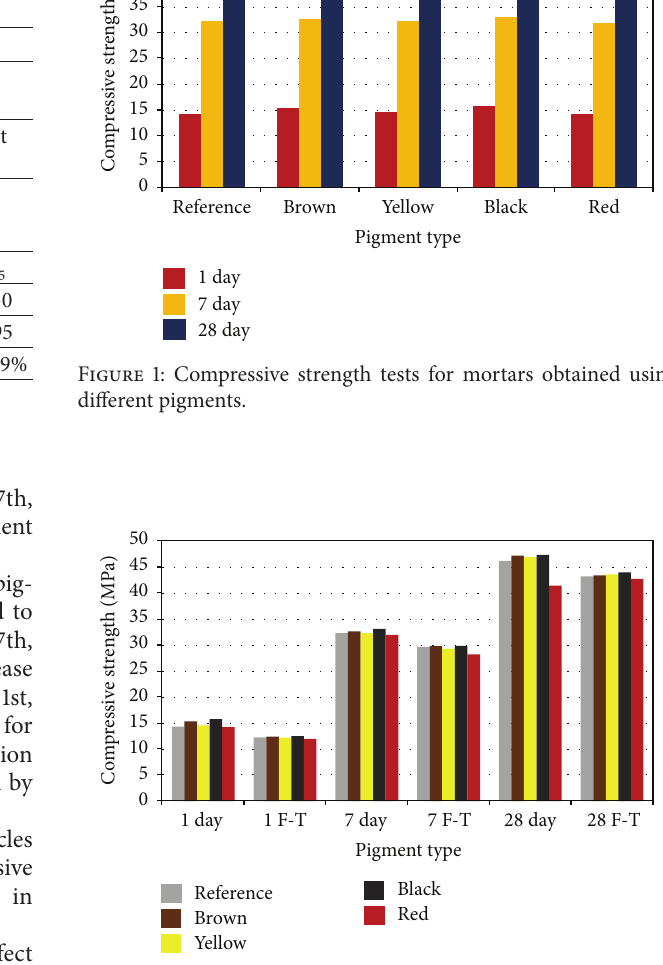
Figure 2: Results of the F-T tests conducted on the mortar samples.